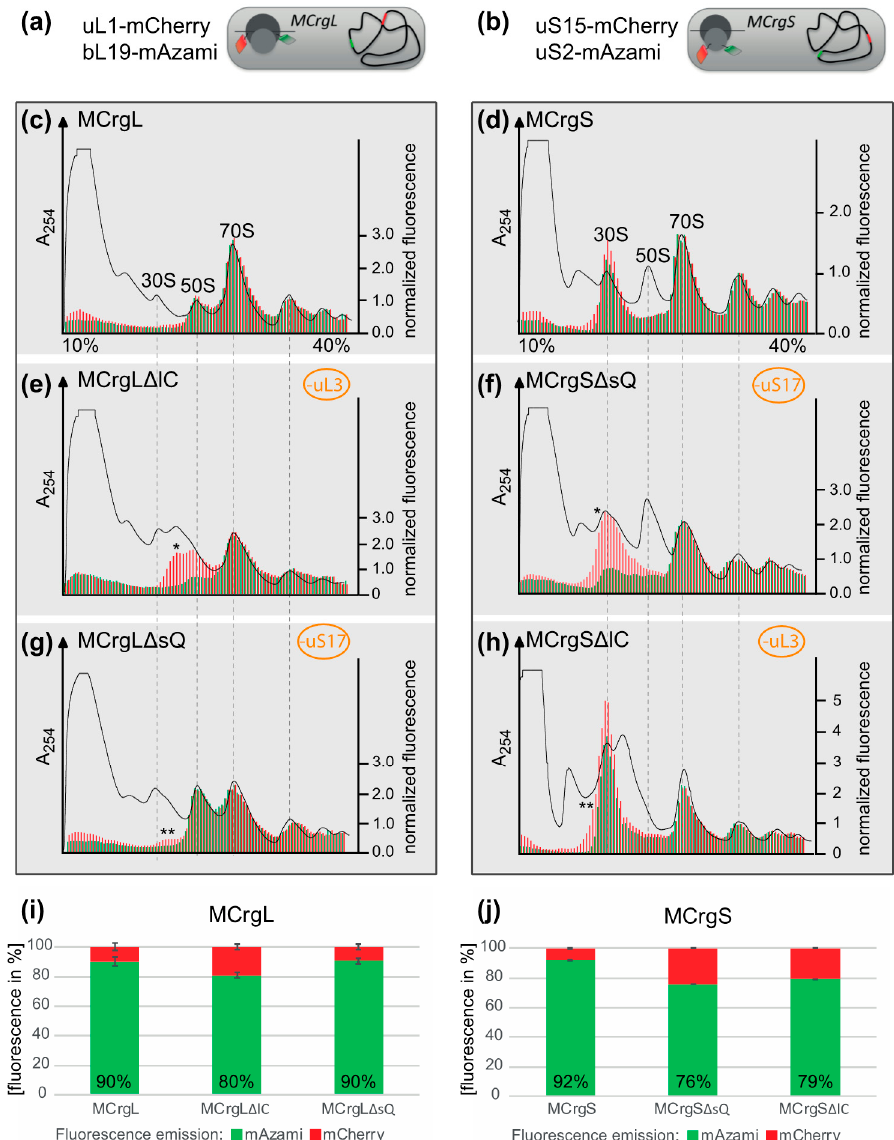
Figure 6. Ribosome profiles after sucrose density gradient centrifugation and fluorescence detection. ( a , b ) schematic drawing of MCrgL and MCrgS*, respectively. Depicted are the positions of the fluorescent proteins and their coding sequences. Dark gray : large ribosomal subunit; light gray : small ribosomal subunit; green barrel: EGFP; red barrel: mCherry; gray line: mRNA; curved black line: bacterial chromosome with red and green strips symbolizing coding sequences of mCherry and mAzami, respectively; ( c – h ) Ribosome profiles derived from MCrgL ( c ), MCrgL ∆ lC ( d ), MCrgL ∆ sQ ( e ), MCrgS ( f ), MCrgS ∆ sQ ( g ) and MCrgS ∆ lC ( h ); A 254 profiles are given in black lines, mCherry and mAzami specific fluorescence intensities are given as red or green bars, respectively. Fluorescence intensities were normalized to the first polysome peak. Red and green fluorescence intensities were calculated and compared to each other, ( i , j ). Total mCherry and mAzami specific fluorescence emission of each strain’s profile is given in bar charts. mCherry signals were set to 100% and mAzami signals are given as relative values. Error bars show S.D. of two independent experiments. One asterisk indicates additional peak or shoulder within the subunit with the primary defect, two asterisks indicate additional peak or shoulder within the subunit was not targeted for assembly defect.